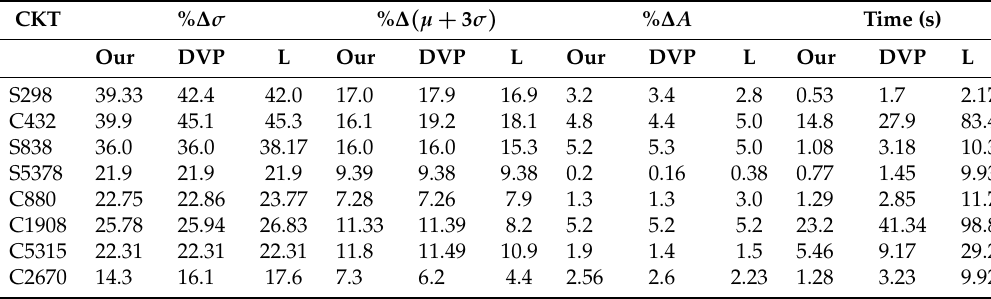
Table 2. Optimization results of our proposal, DVP and